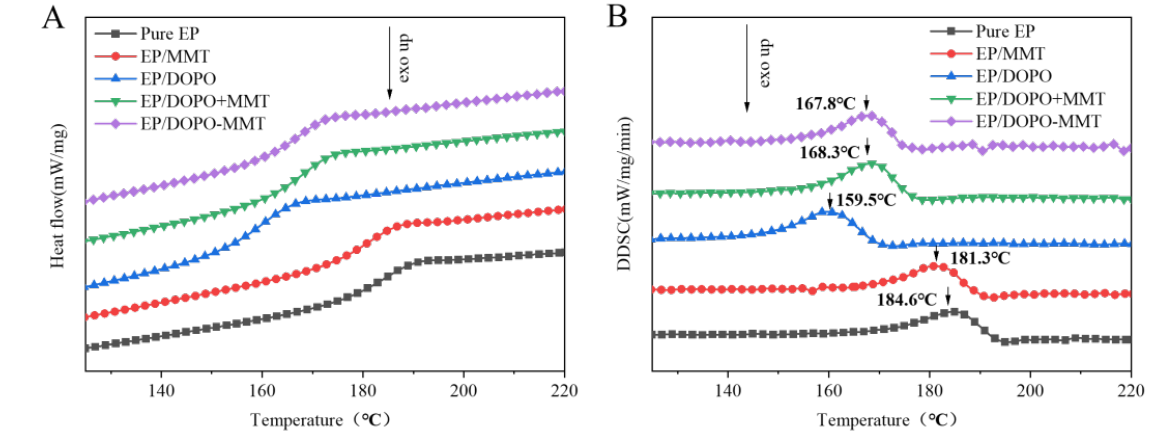
Figure 7. DSC ( A ) and DDSC ( B ) curves of EPs. Table 4. CONE data of epoxy resin composites.